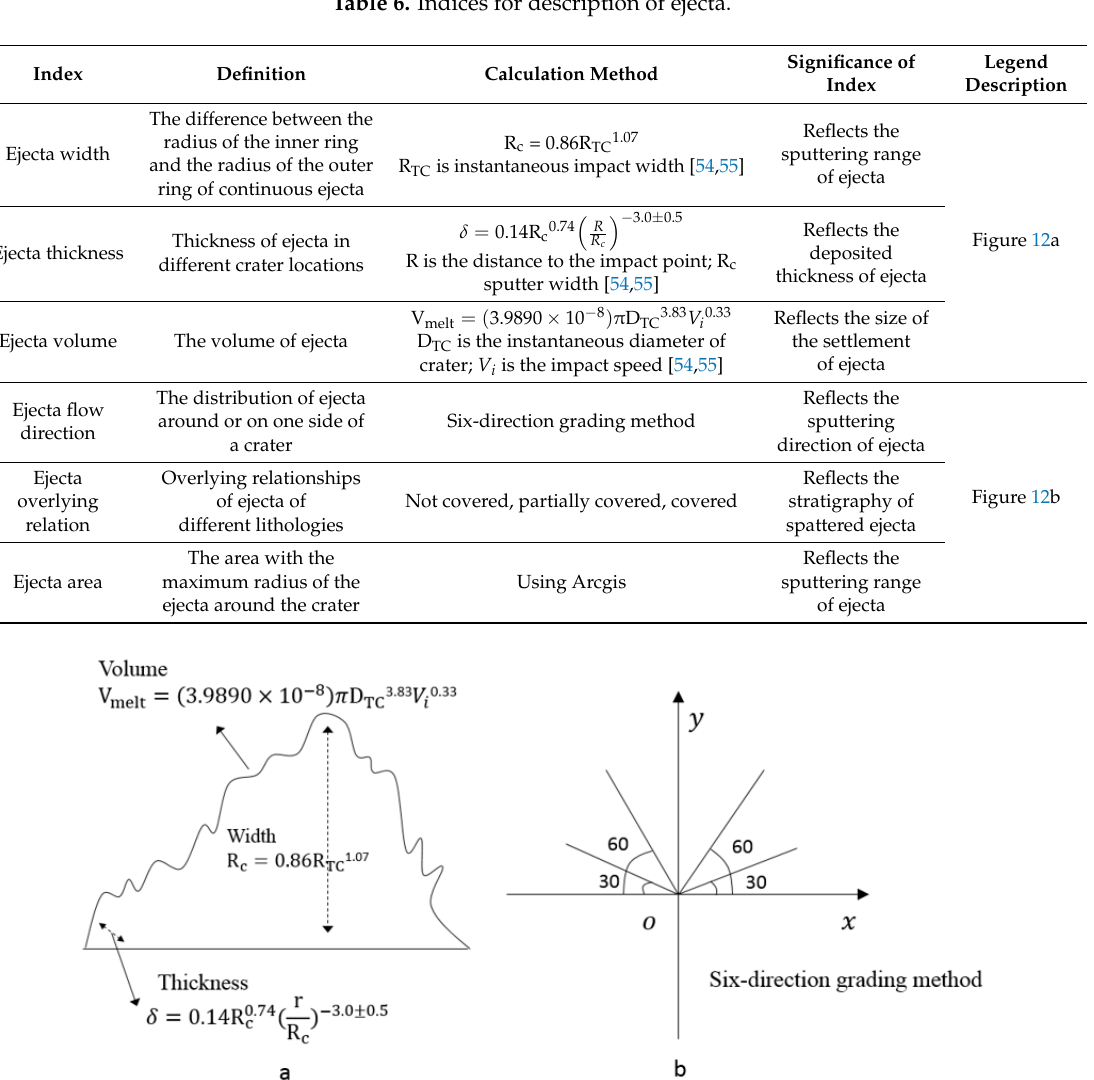
Figure 12. Schematic description for some of the indices in Table 6. ( a ) Ejecta volume; ( b ) Ejecta flow direction.